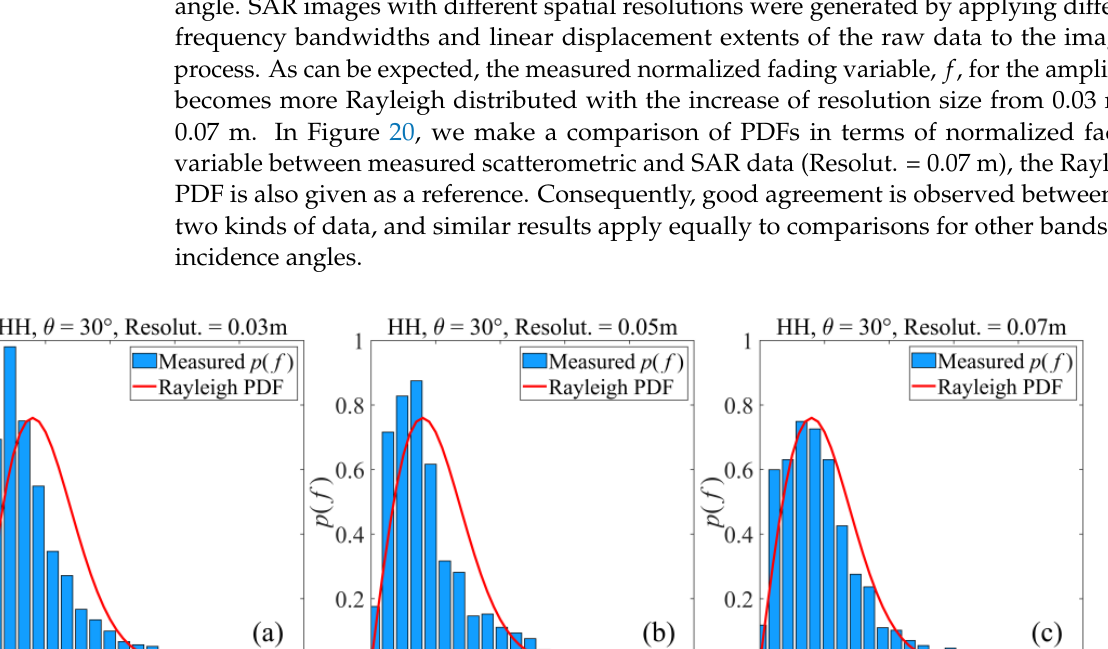
Figure 20. Comparison of amplitude statistics between scatterometric and SAR data (Resolut. = 0.07 m) at ( a ) HH, ( b ) VV, ( c ) HV, and ( d ) VH polarizations.